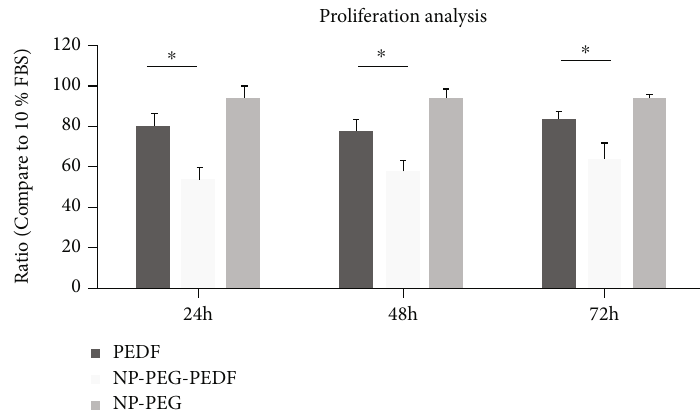
Figure 2: E ff ects of PEDF and NP-PEG-PEDF on the proliferation of HUVECs in the general culture medium under high glucose (30 mmol/L) at 24, 48, and 72 h. The e ff ective concentrations (1000ng/mL) at di ff erent time points are shown. ∗ p < 0 : 05 . Table 1: Summary of proliferation e ff ects with PEDF and NP-PEG-PEDF-treated HUVECs under high glucose (30 mmol/L). Time points